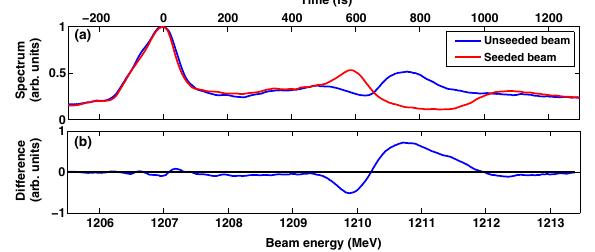
FIG. 5 (color online). (a) Profiles of the electron-beam density measured in MBD in case of a seeded (red) and unseeded (blue) beam. (b) Difference between the two profiles, showing the charge difference and the hole in the energy distribution produced by the seeding.